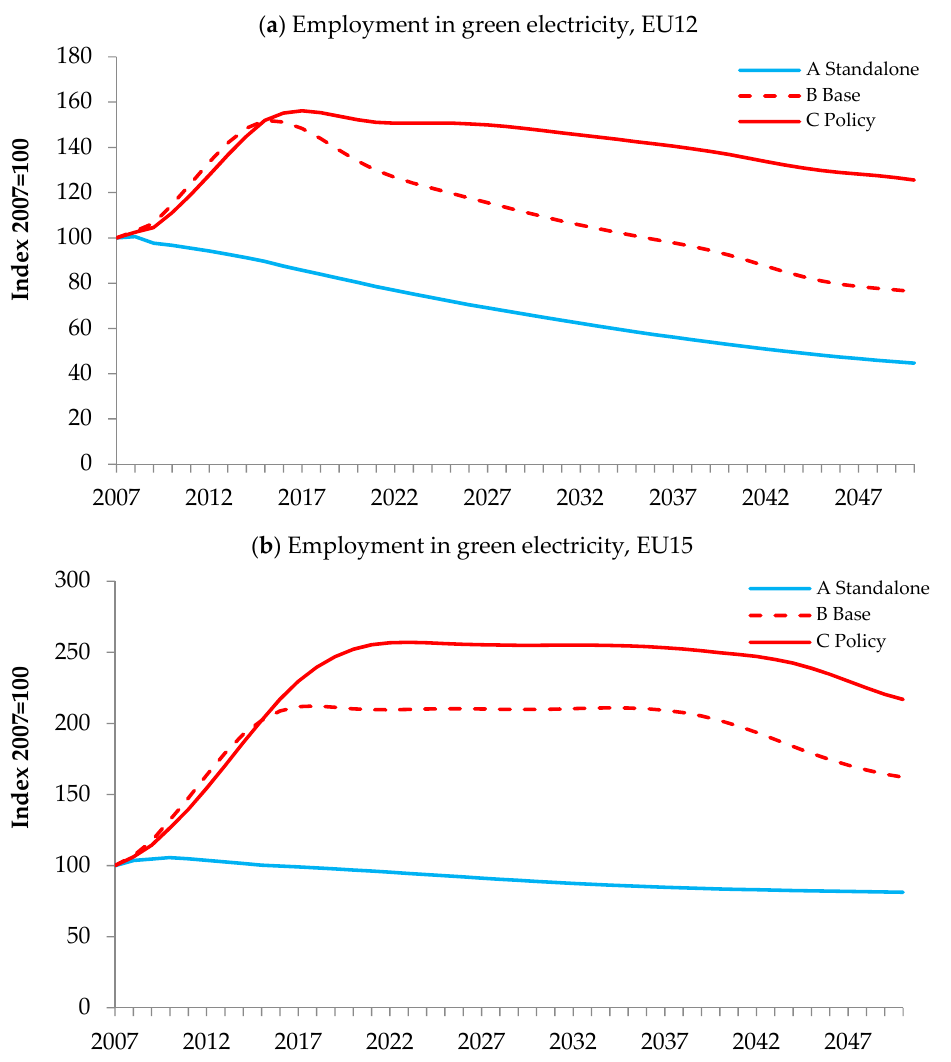
Figure 9. Employment in green electricity, using A, B, and C settings, in ( a ) EU12 countries, and ( b ) EU15 countries.